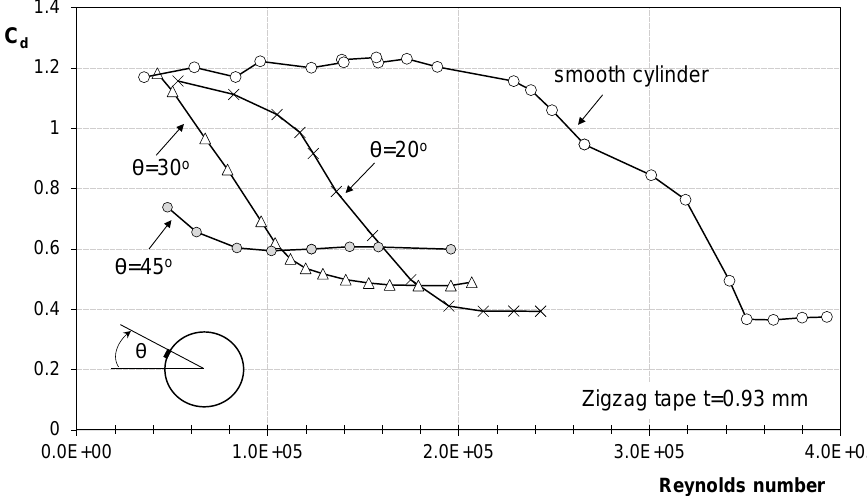
Figure 4. The impact of zigzag tape location on the drag coefficient of a smooth cylinder. Tape on the left and the right from the leading edge. Tape thickness is 0.93 mm; cylinder span is 60 cm .